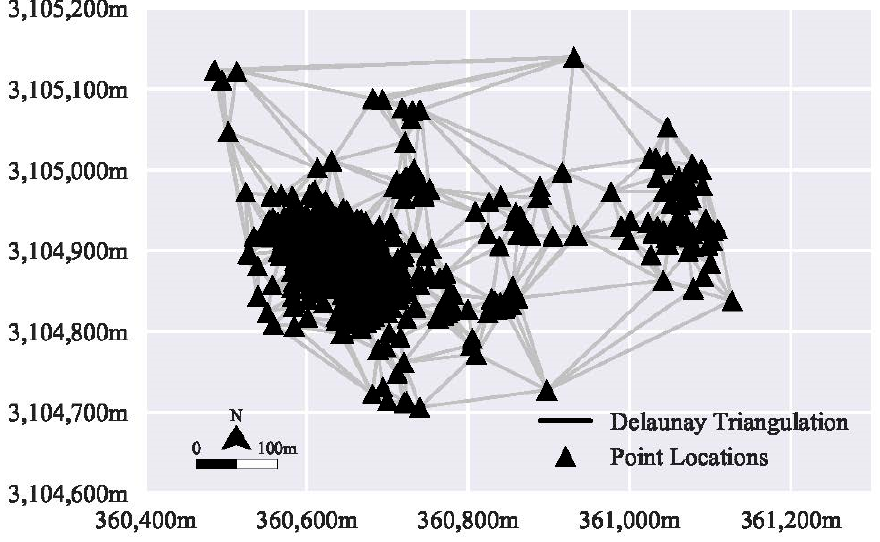
Figure 1. Example of a Delaunay Triangulation using animal tracking points.